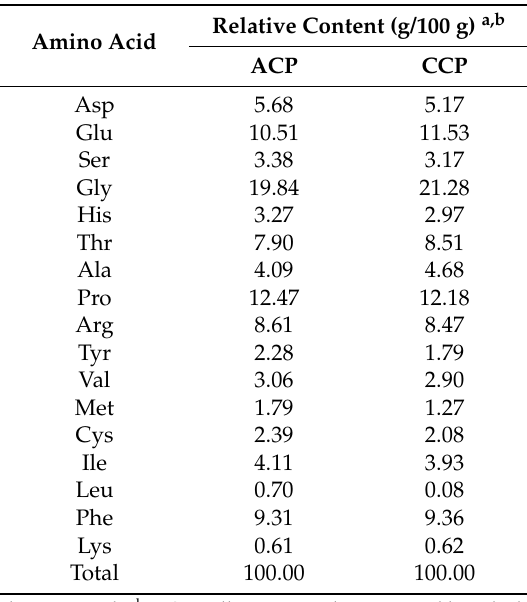
Figure 1. The molecular weight distributions of collagen peptides. Table 1. Amino acid compositions of collagen